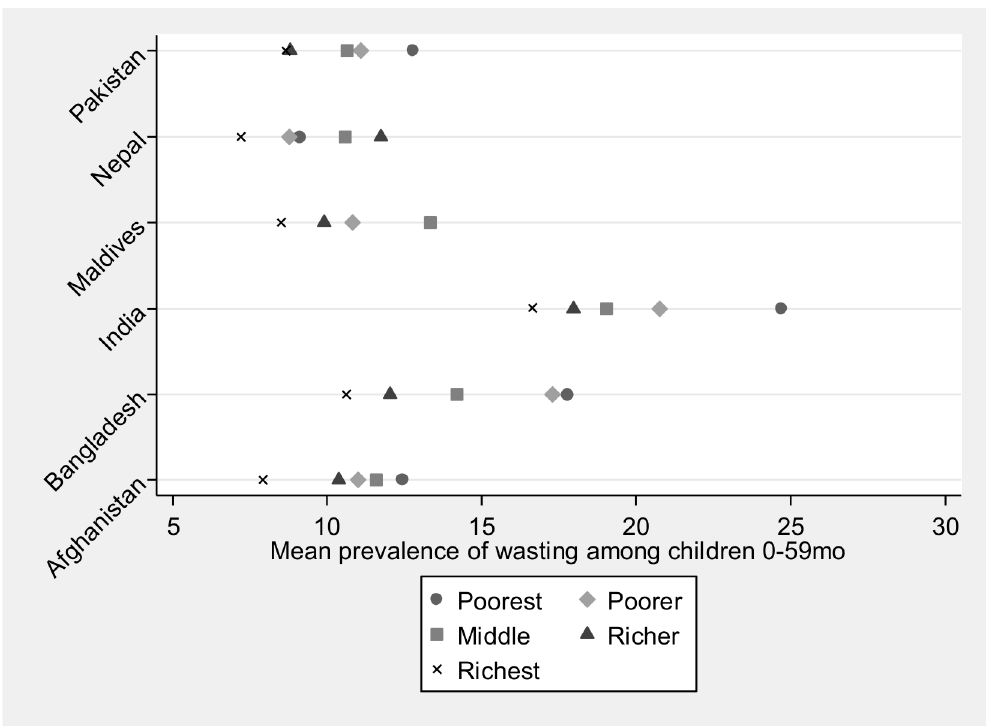
Fig 2. Prevalence of wasting among children 0–59 months old by wealth